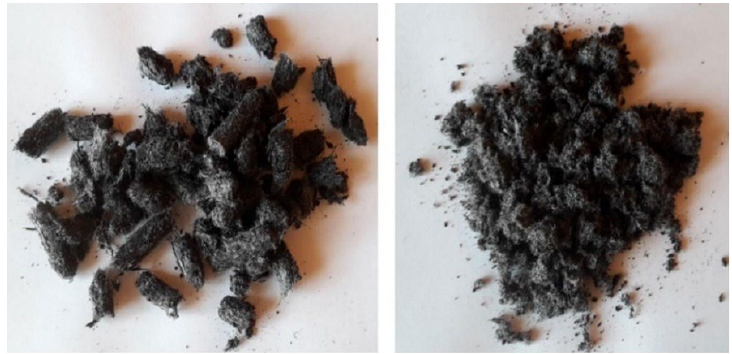
Figure 11. Effect of the fiber type in reducing bitumen drain down from porous asphalt mixtures [99].